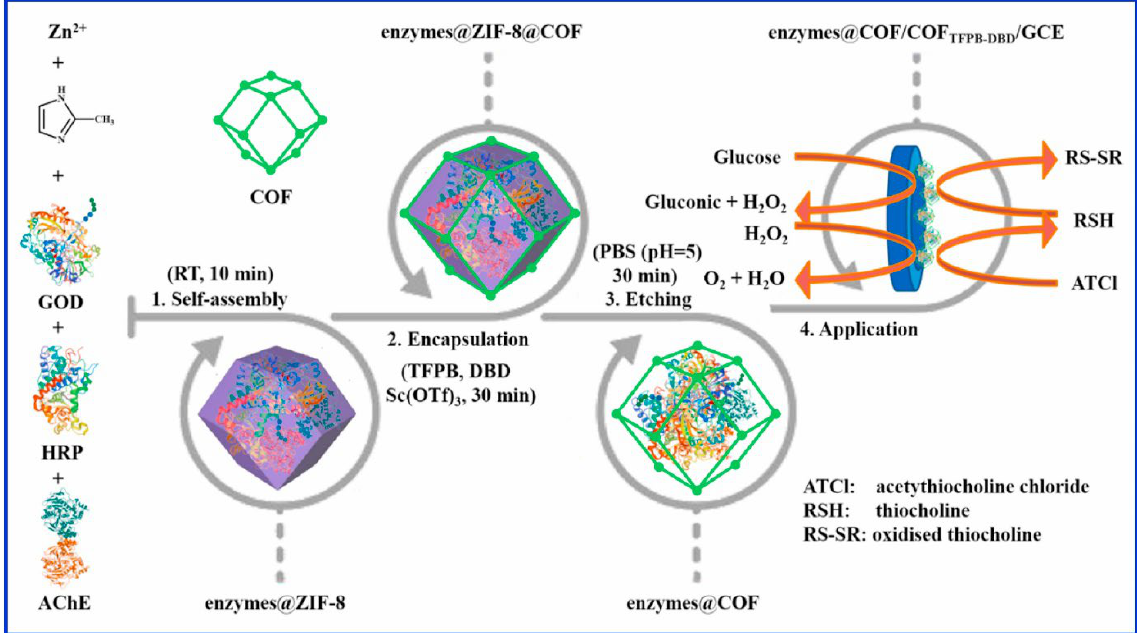
Figure 7. Synthesis of GOD, HRP, and ACLE-loaded COF microcapsules and the electrochemical biosensing of glucose, H 2 O 2 and malathion. Reproduced with permission from [144].